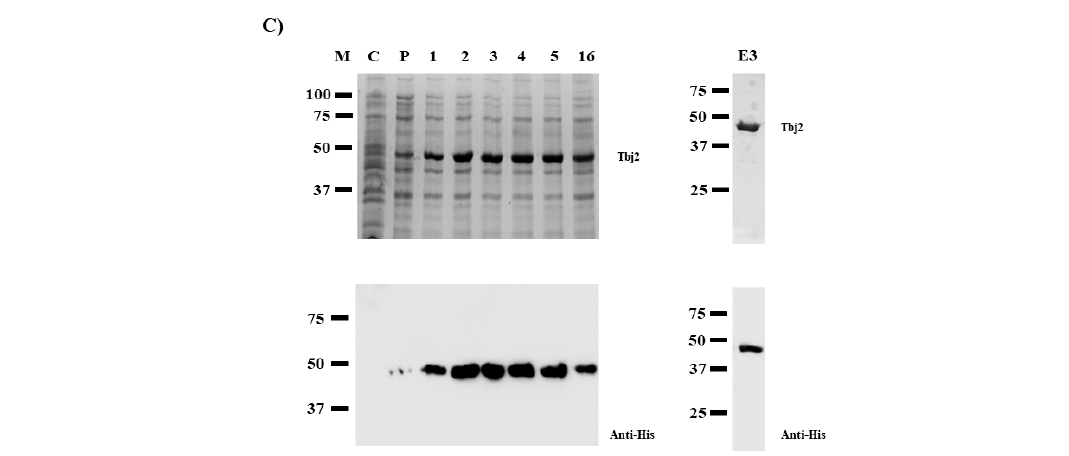
Figure 1. Expression and purification of recombinant TbHsp70, TbHsp70.4, and Tbj2. TbHsp70 and TbHsp70.4 were both expressed in E. coli XL1 Blue cells, and Tbj2 was expressed in E. coli BL21 (DE3) cells. SDS-PAGE (10%) and Western blot images representing the expression and purification of the recombinant forms of TbHsp70 ( A ), TbHsp70.4 ( B ), and Tbj2 ( C ). Lane M: Marker in kilodalton (kDa) (Precision Plus Protein TM All Blue Prestained Protein Standard) is shown on the left-hand side; Lane C: The total extract for cells transformed with a neat pQE2 plasmid (TbHsp70 and TbHsp70.4) or transformed with a neat pET28a plasmid (Tbj2). Lane P: The total cell extract of E. coli XL1 Blue cells transformed with either pQE2 / TbHsp70 or pQE2 / TbHsp70.4, and E. coli BL21 (DE3) cells transformed with pET28a / Tbj2 prior to 1 mM IPTG induction; Lanes 1–16: Total cell lysate obtained 1–16 h post IPTG induction, respectively. Lanes E1–3: TbHsp70, TbHsp70.4, and Tbj2 proteins eluted from the a ffi nity matrix using 500 mM imidazole. Lower panels: Western blot analysis using anti-His antibody to confirm expression and purification of recombinant TbHsp70, TbHsp70.4, and Tbj2. Western blot analysis using anti-TbHsp70 and anti-TbHsp70.4 to confirm expression of recombinant TbHsp70 and TbHsp70.4 were also used,